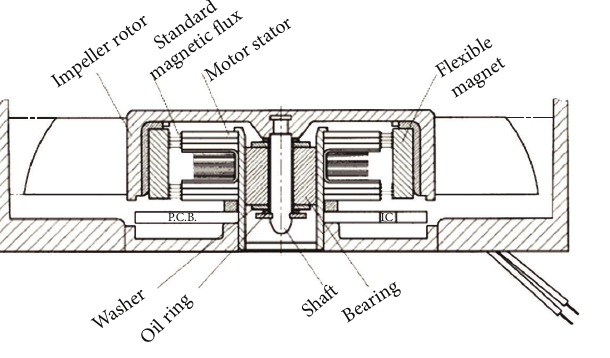
Figure 22: Ball bearing.